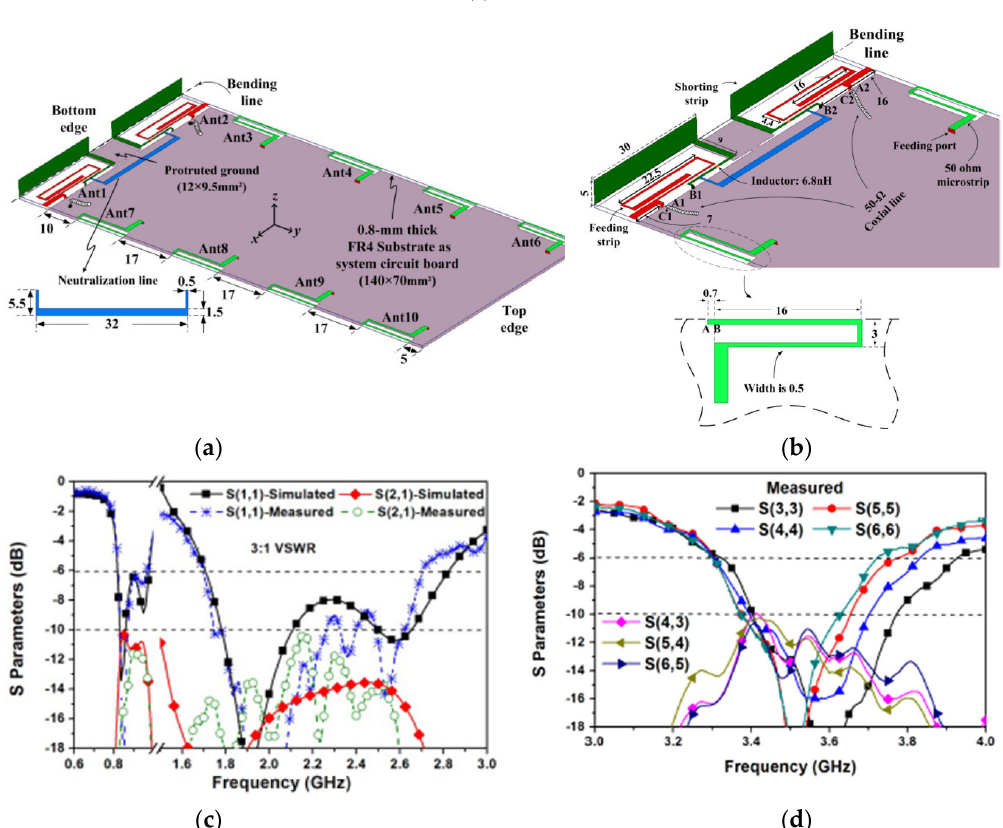
Figure 12. Configuration of MIMO antenna [69], ( a ) whole structure, ( b ) 4G and 5G modules, and ( c , d ) simulated and measured S−parameters.